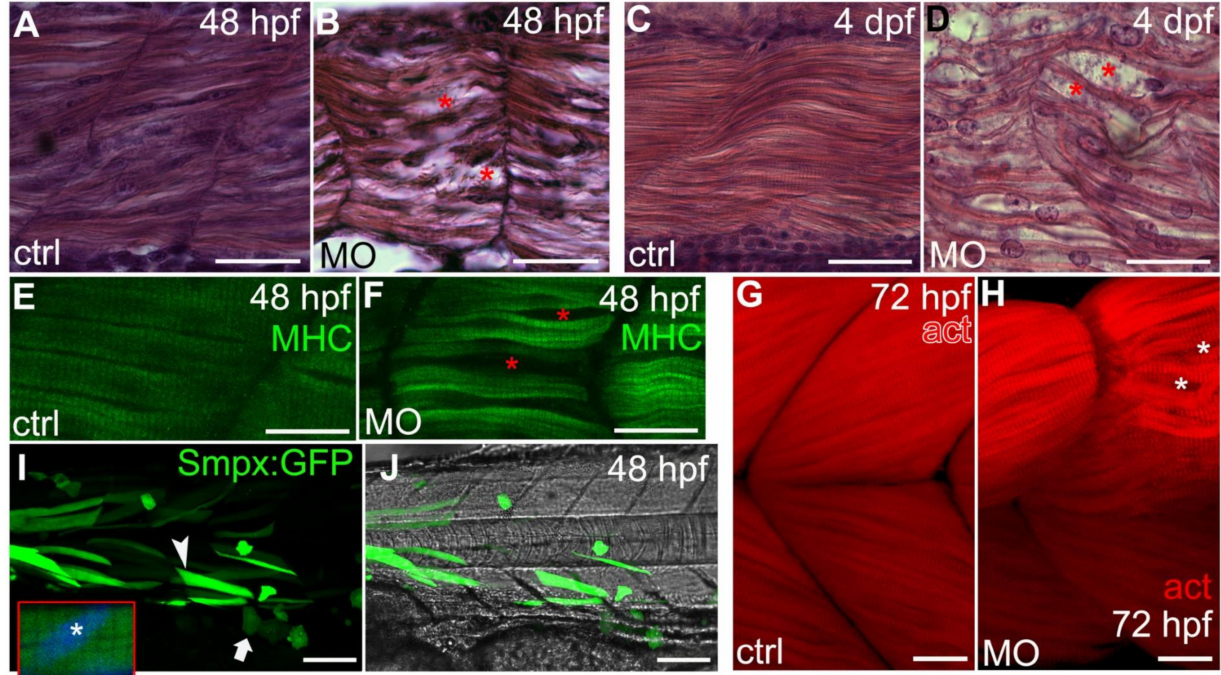
Figure 2. smpx knockdown disturbs the proper fiber arrangement during development. ( A – D ) side views, anterior left, dorsal top. Paraffin sections of Control-MO ( A , C ) and smpx-MO ( B , D ) injected embryos at 48 hpf ( A , B ) and 4 dpf ( C , D ). The red asterisks indicate alterations in the muscle array. ( E – H ) side views, anterior left, dorsal top. Confocal Z-stacks taken from whole-mount embryos (48 hpf) and larvae (72 hpf) labelled with ( E , F ) myosin heavy chain (MHC) antibody for slow fibers and ( G , H ) phalloidin (act) for actin filaments of the fast fibers. The red ( F ) and white ( H ) asterisks indicate alterations in the normal muscle array (controls in ( E , G ), respectively). ( I,J ) representative lateral view of an embryo injected with the construct encoding the Smpx:GFP chimera (see Figure S1A for construct details); muscle fibers (arrowhead) and epithelial cells (arrow) are both uniformly painted with no accumulation of Smpx:GFP in the nuclei. Inset: magnification of a slow fiber with the nucleus (asterisk) labelled with DAPI (blue). Anterior left, dorsal top. Scale bars = 25 µ m in ( A – D ); 20 µ m in ( E , F ); 20 µ m in ( G , H ); 100 µ m in ( I , J